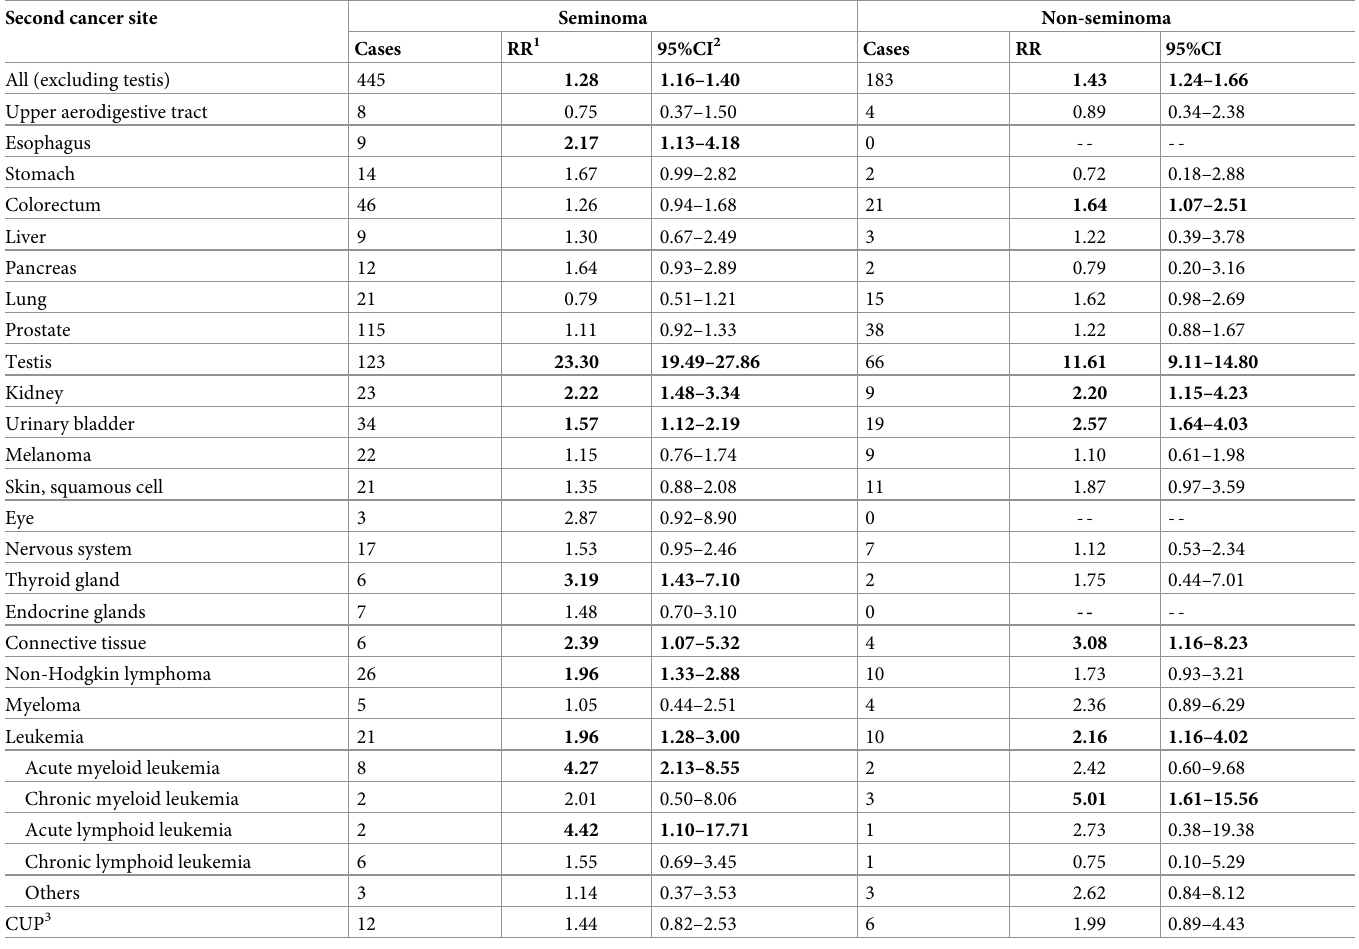
Table 4. RRs of second primary cancers after seminoma and